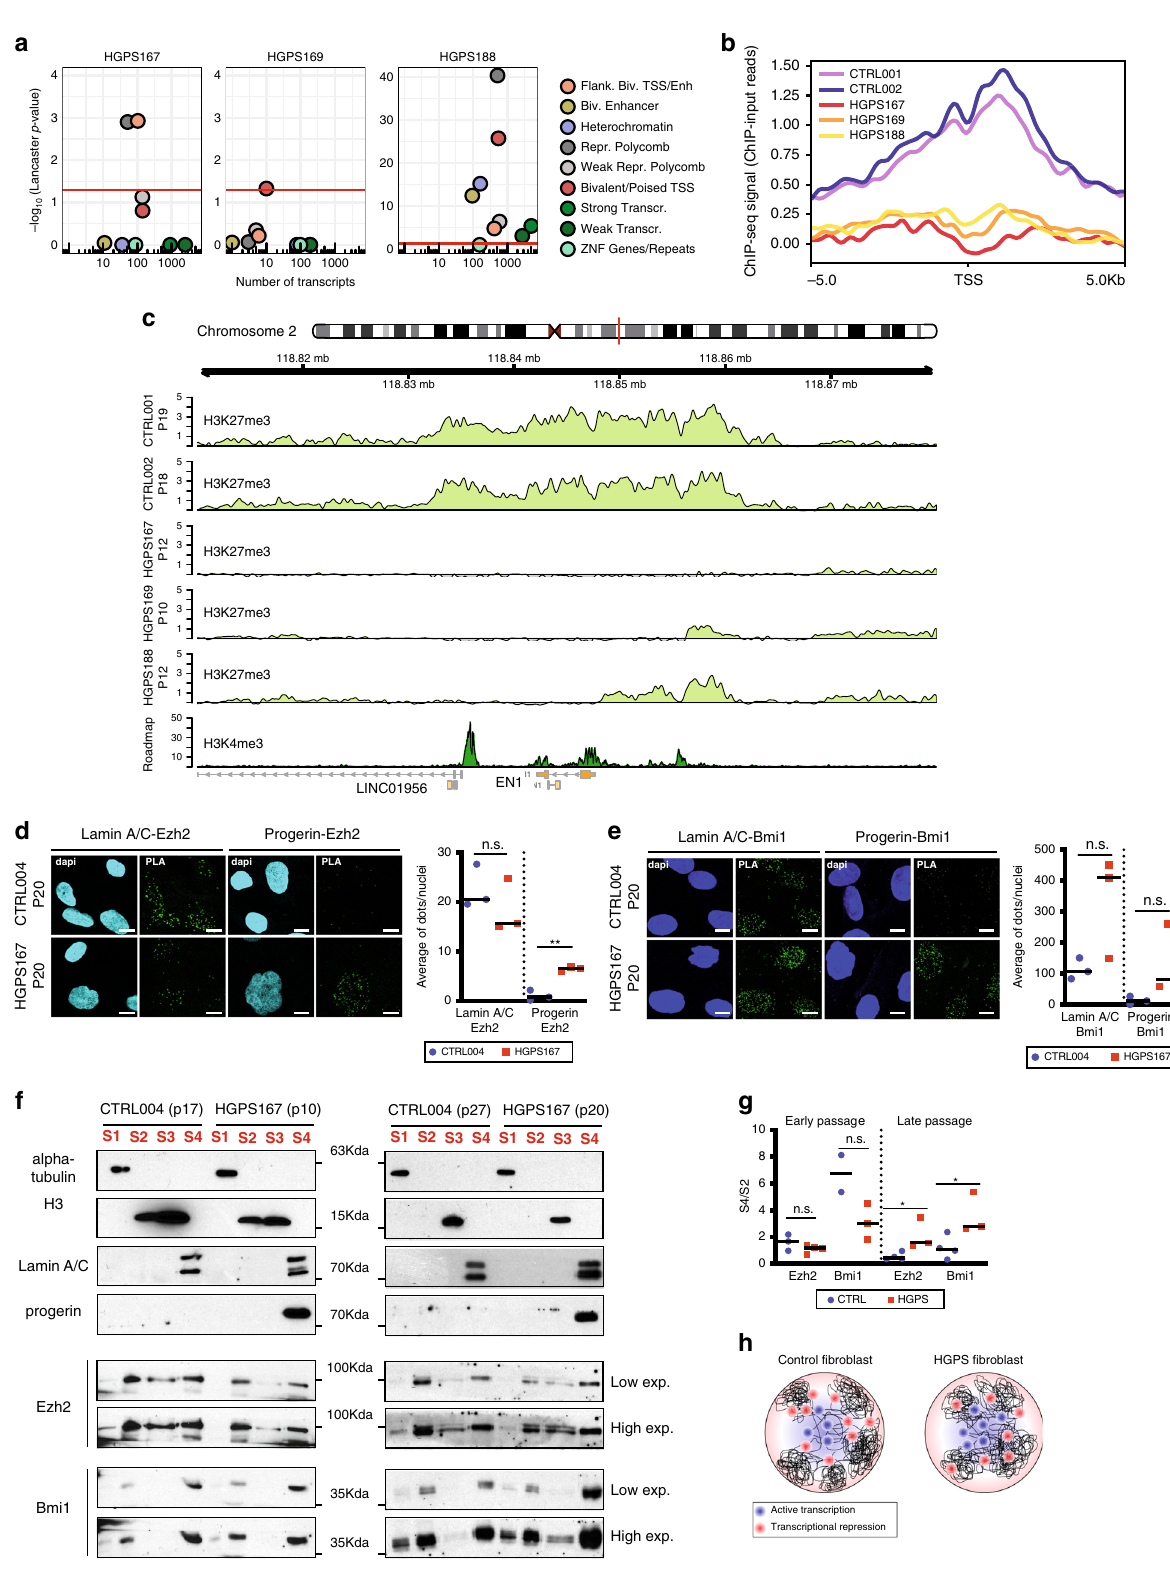
(AC22 Cell Signaling 3147S, mouse 1:1000), Bmi1 (D42B3 Cell signaling, rabbit 1:1000) were used as primary antibodies. HRP-conjugated secondary antibodies were revealed with the ECL chemiluminescence kit (Thermo Fisher Scienti fi c). DNA sonication and sequencing for chromatin fractionation . For DNA analysis, the remaining 30% of the volume of each fraction was diluted to 300 μ l with